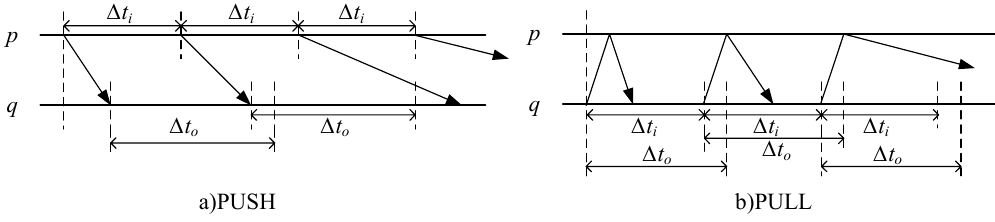
Figure 1. Heartbeat detection